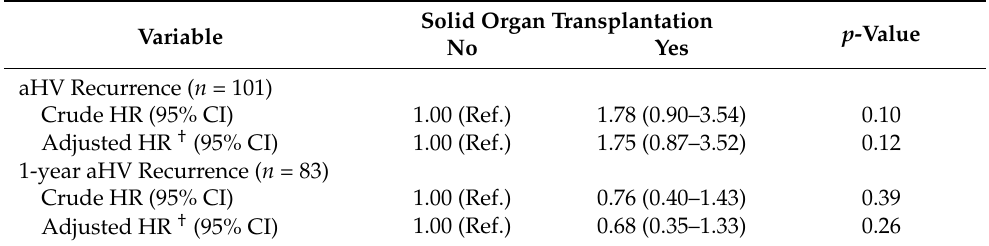
Table 5. Recurrent risk of aHV infection in groups through competing-risks